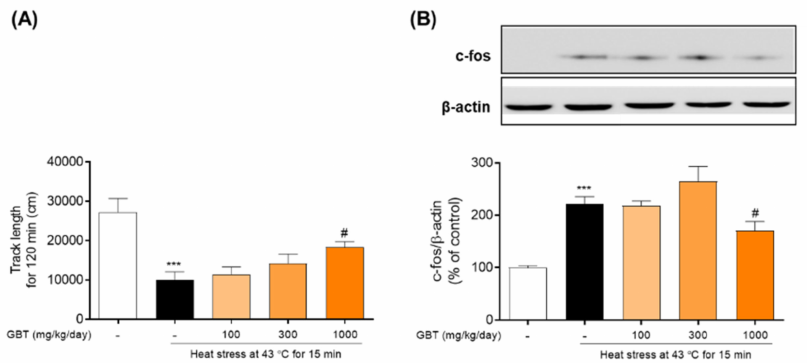
Figure 2. Protective effect of GBT on heat stress-induced behavior impairment and hypothalamic c-fos overexpression. Open-field test (n = 6 per group) was performed 3 h after heat exposure ( A ). Quantification of densitometric analyses was performed by measuring the expression ratios of c- fos/ β -actin (n = 6 per group) in the lysates of hypothalamus for investigating the effects of GBT ( B ). Values are expressed as means ± SEM. *** p < 0.001 as compared with the control group. # p < 0.05 as compared with the heat-exposed vehicle-treated group. GBT; Geongangbuja-tang